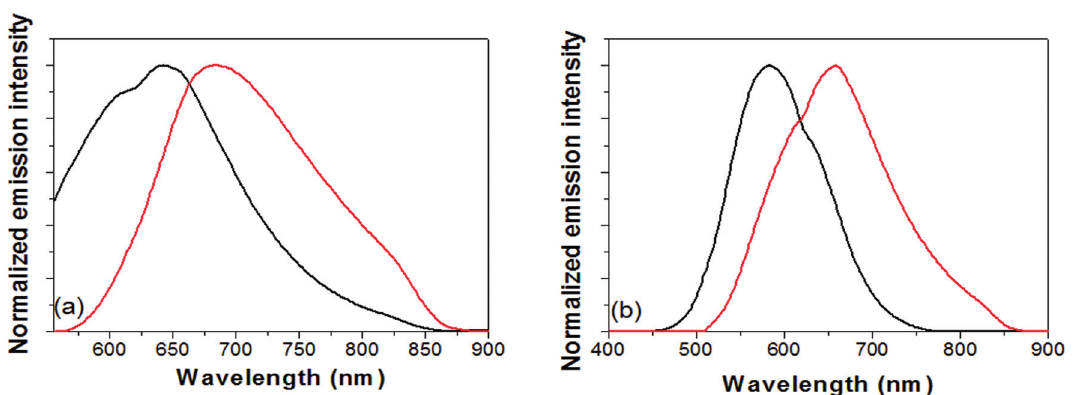
Figure 11: Component spectra for CdSe QDs bearing different surface ligands: (a) MPA and (b)